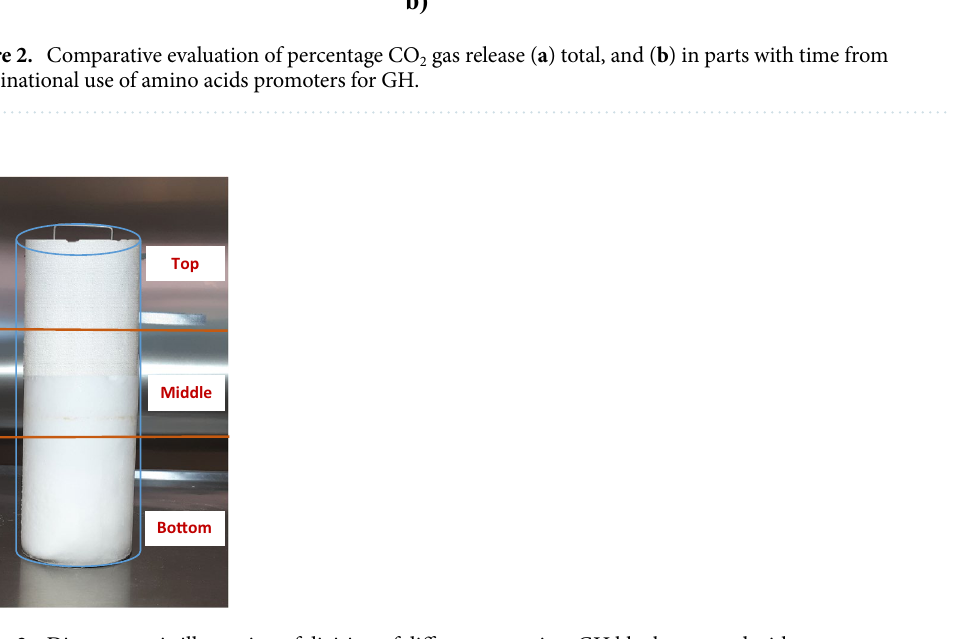
Figure 3. Diagrammatic illustration of division of different zones in a GH block prepared with